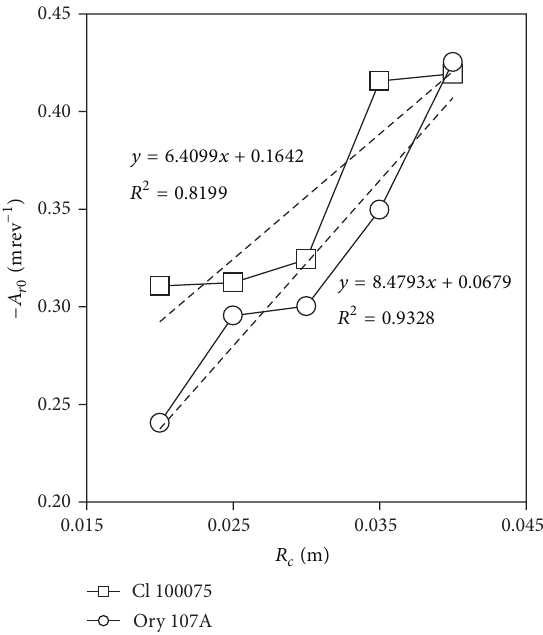
Figure 8: Constant term of the slope for calibration coefficient 𝐴 𝑟0 (see expression (4)) from the testing results, as a function of ane- mometer cup radius, 𝑅 𝑐 . Linear fittings have been added to the